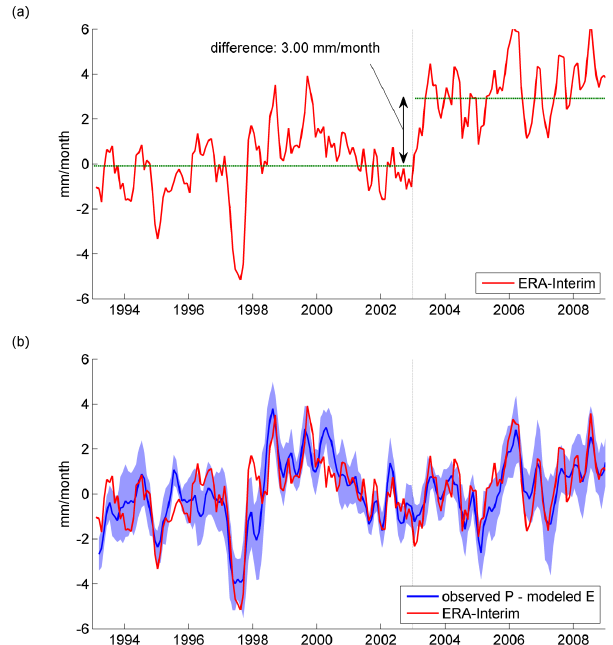
Fig. 5. (a) Interannual variability of precipitation minus evapotran- Figure 5: (a) Interannual variability of precipitation minus evapotranspiration over land (P l -E l ) 4 spiration over land ( P l – E l ) computed from the atmospheric water computed from the atmospheric water budget and ERA-Interim data. (b) Corrected P l -E l with 5 a uniform offset of -2.78 mm/month over 2003-2009, and observed P l minus modeled E l used 6 budget and ERA-Interim data. (b) Corrected P l – E l with a uniform to find the optimum offset (blue shading represents discrepancies between P l -E l obtained from 7 offset of − 2.78mmmonth − 1 over 2003–2009, and observed P l mi- the different the data sets). 8 9 nus modeled E l used to find the optimum offset (blue shading rep- resents discrepancies between P l – E l obtained from the different the data sets).